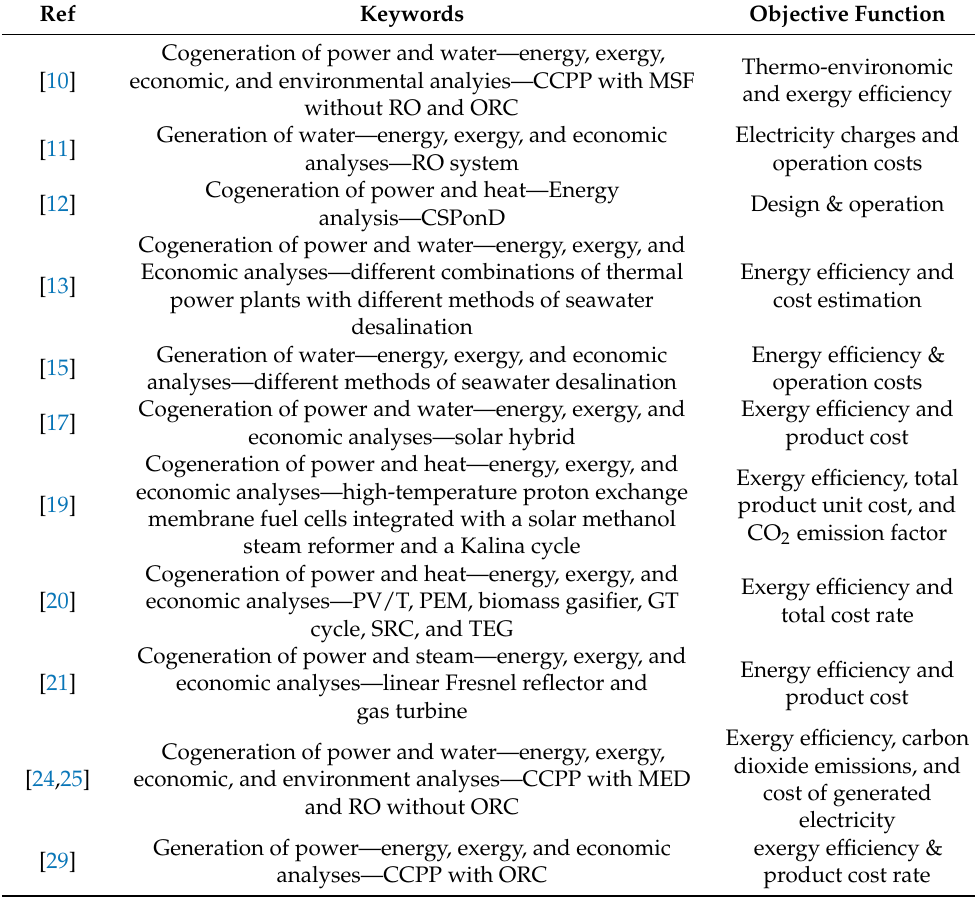
Table 1. The differences in articles similar to this